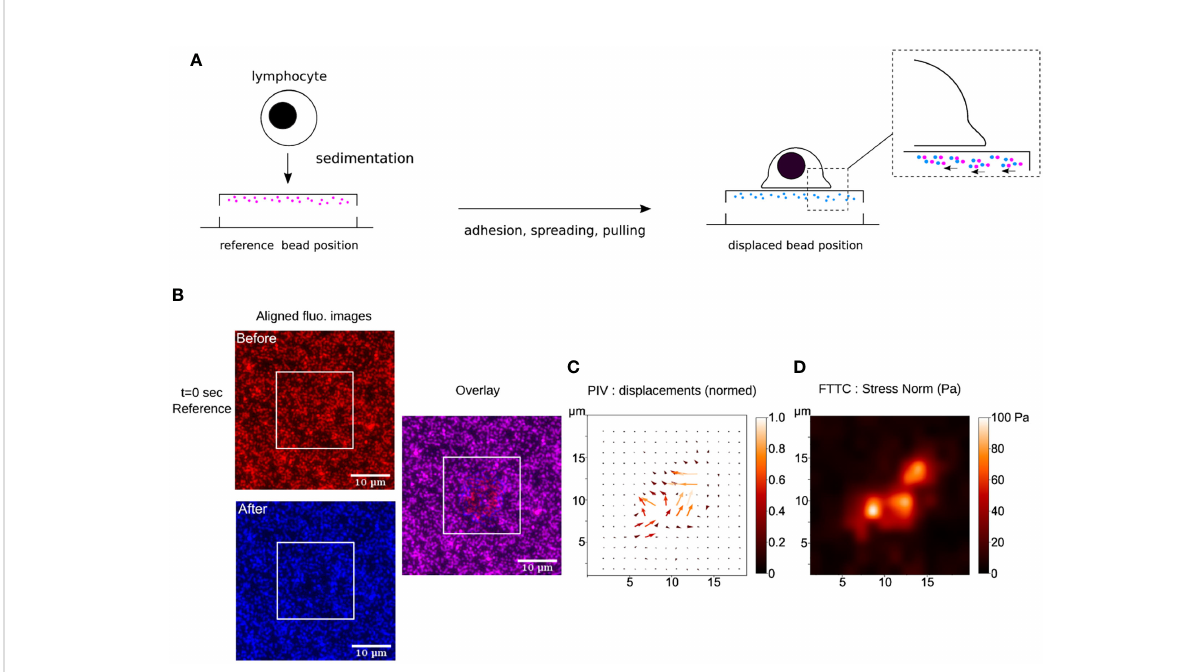
calculation showing the gaussian smoothed map of stress norm. The data presented here has been processed using open-source softwares (Fiji/ImageJ (61), Python), following